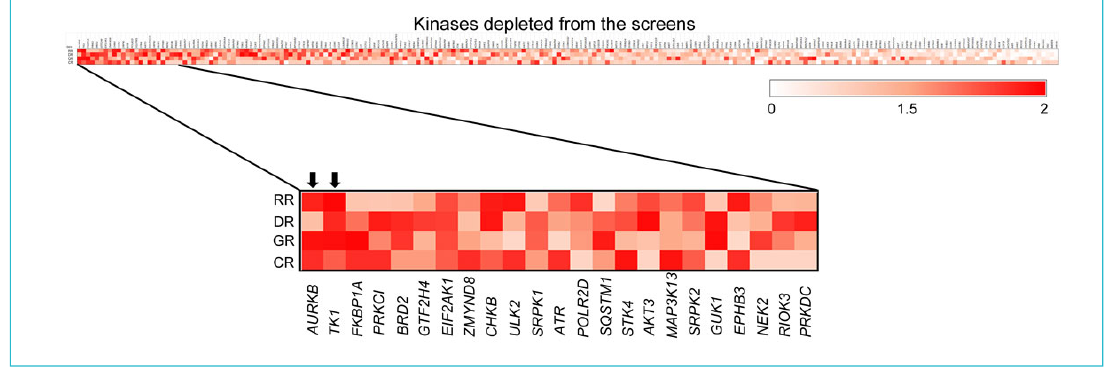
Figure 2: Heatmap representation of depleted kinases in the screen considering overall Rank Impact Score (RIS). Heatmap represen- tation of the kinases depleted in the screen which have a high impact score according to the ranking assigned by considering ROAST, gene expression data, copy number data and the average logFC of the depleted shRNA for that kinase. The enlarged view shows the top 10 kinas- es with the highest impact scores. AURKB and TK1 kinases top the list.